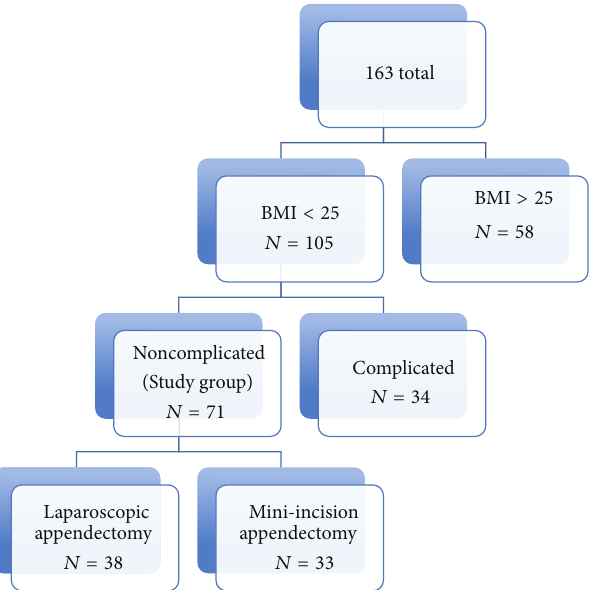
Figure 1: The study group was consisting of the patients whose BMI were lower than 25 kg/m 2 and who had noncomplicated